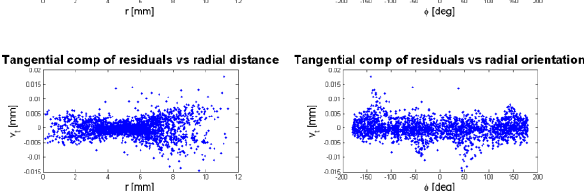
Figure 7. Plots of radial or tangential component of residuals vs. radial distance or orientation after removing the radial lens distortion for the 24 mm lens calibration of the Canon T3 (1100D)